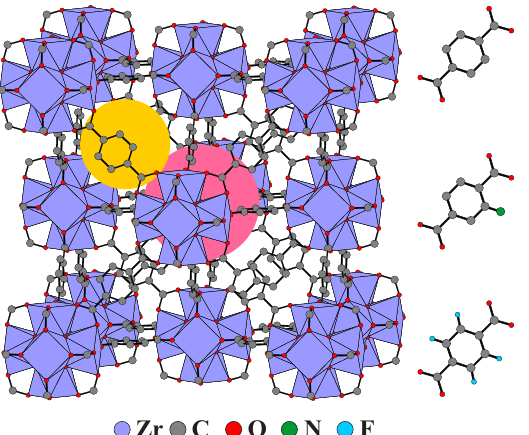
Figure 1. Crystal structure of UiO-66 (left). Examples of octahedral and tetrahedral pores are indicated in pink and yellow, respectively. BDC linker and its functionalized BDC − NH (right). Structural data taken from Ref. [11]. Hydrogen atoms of BDC linkers are not shown for